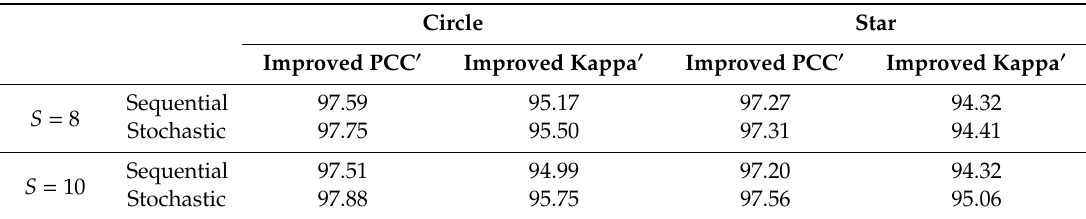
Table 12. Accuracies (%) of two optimization methods for the PSA_MSA2 algorithm.